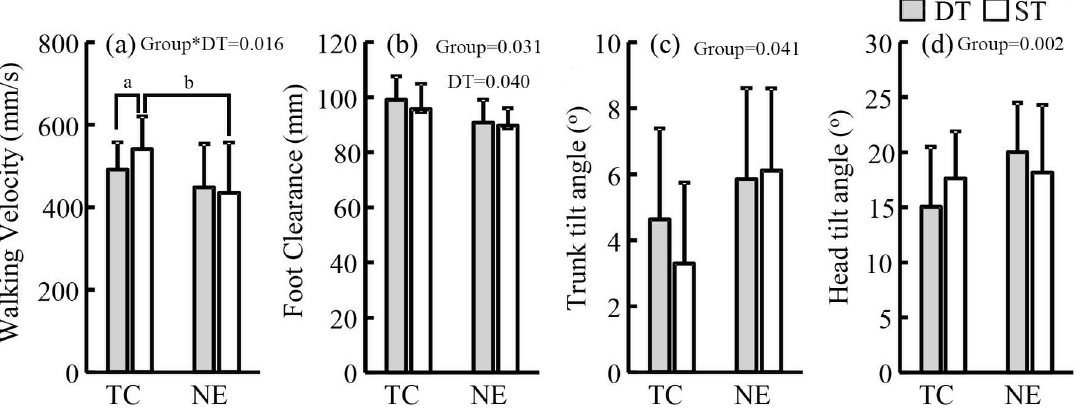
Fig 1. Kinematic variables during stair decent. TC: Tai Chi, NE: no-exercise, DT: dual task, and ST: single task. a: Significant difference between the DT and ST conditions among the TC practitioners. b: Significant difference between TC and NE participants under the ST